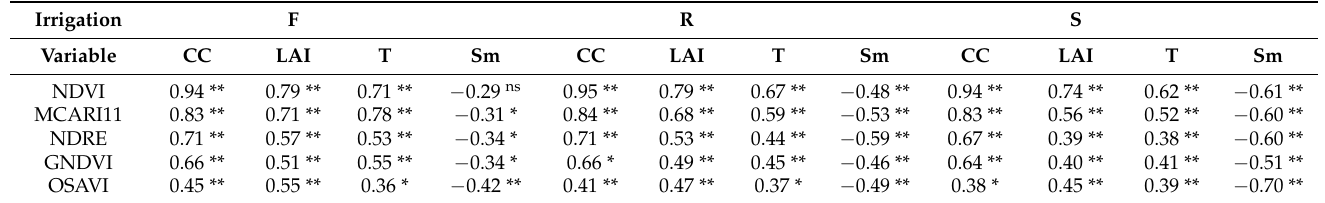
Table 5. Pearson’s coefficients of correlation between average VIs and observed parameters (CC, LAI, soil moisture), and reference and actual evapotranspiration ( ETo , ETa